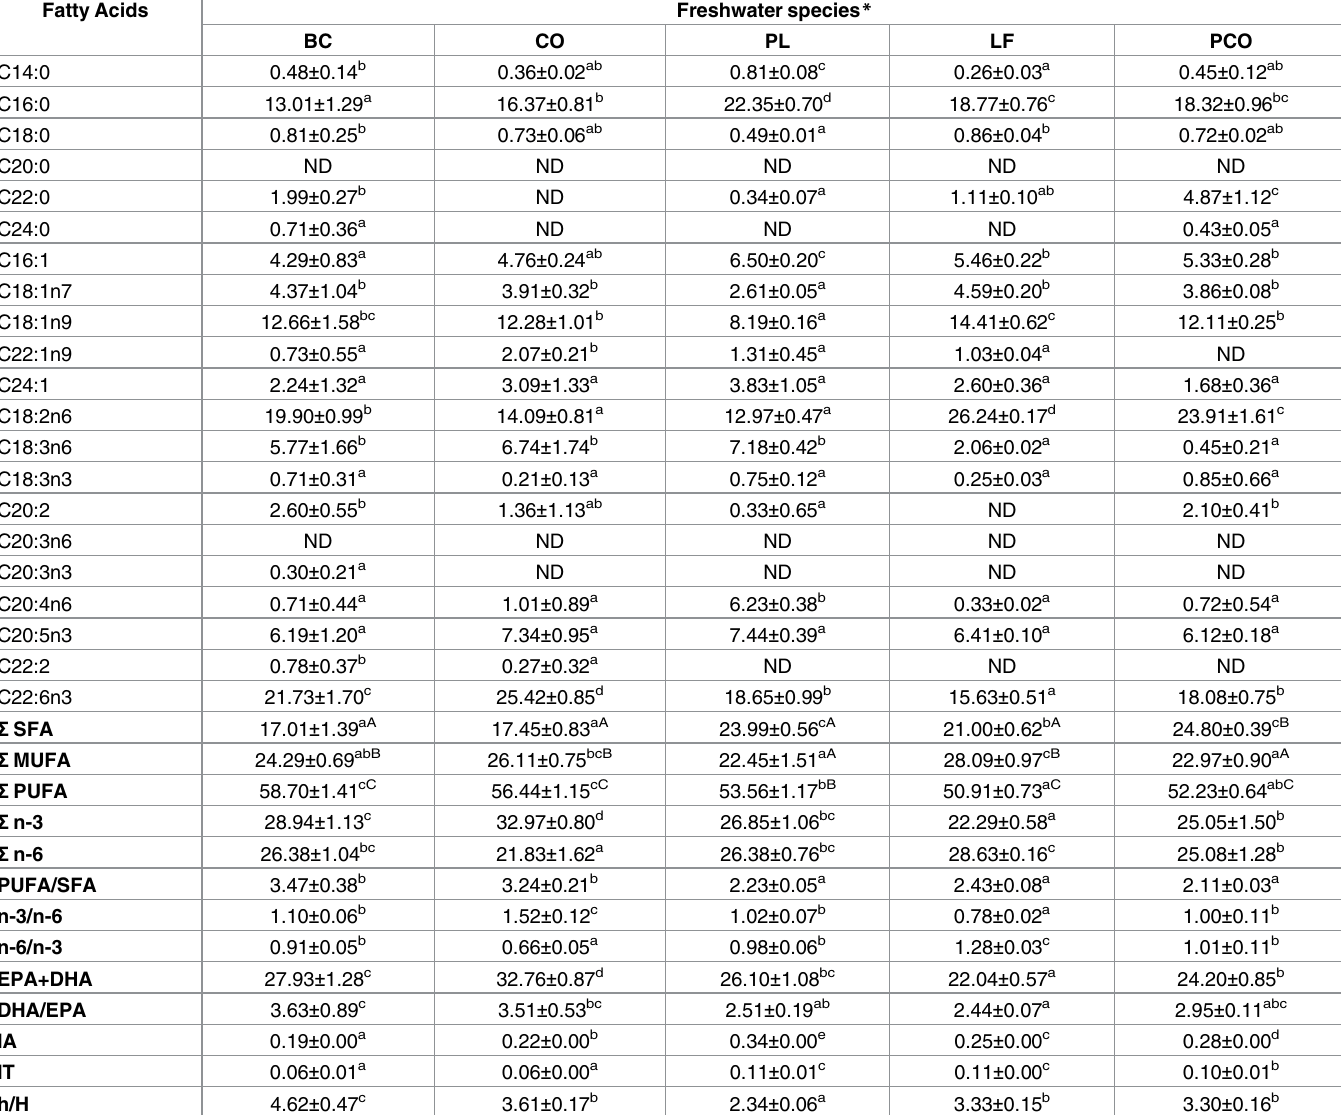
Table 2. Fatty acid profile (% of total fatty acids) and nutritional quality indices in fillets of five Brazilian freshwater fish species. Fatty